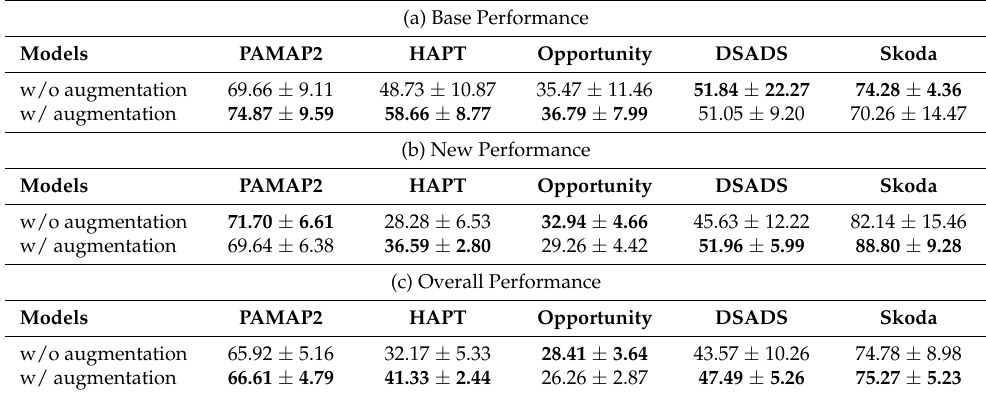
Table 5. Effect of data augmentation with